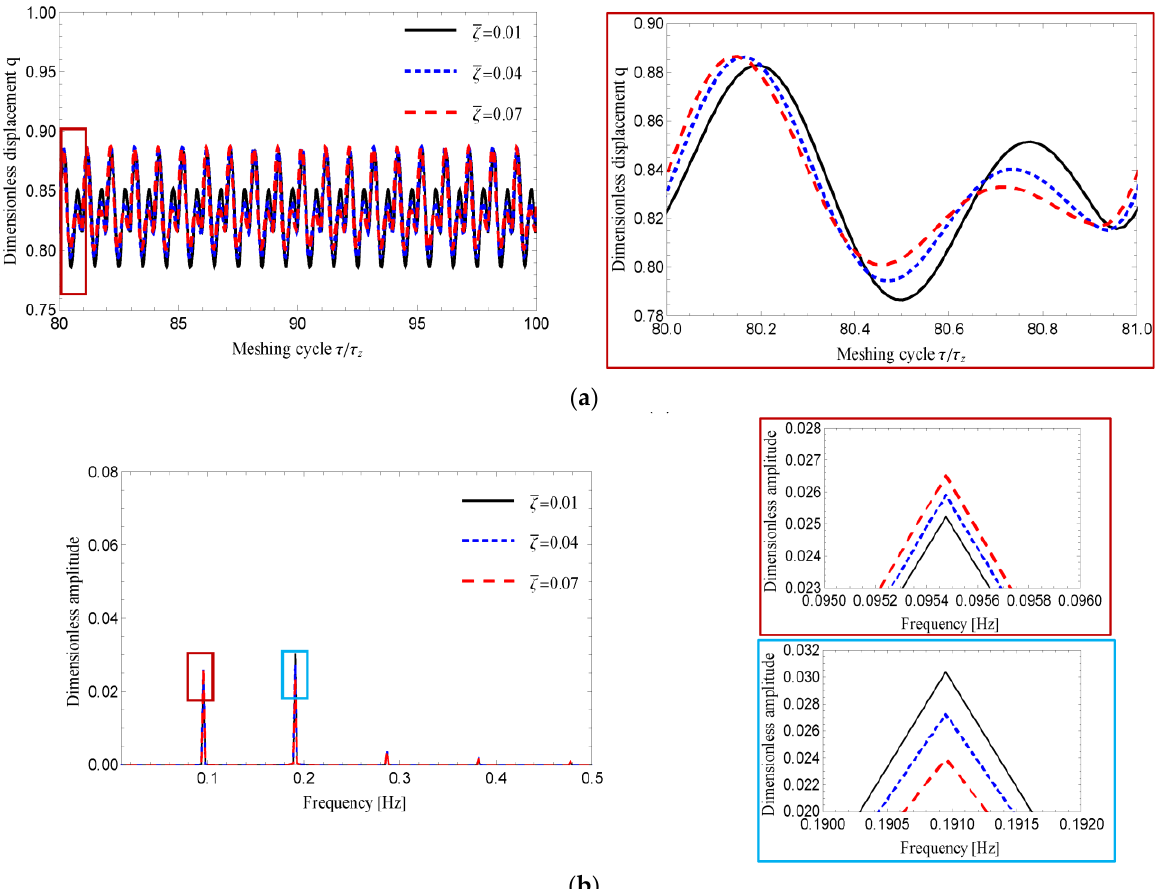
Figure 26. The dynamics characteristics with differen t 𝜁̅ : ( a ) time history diagram; ( b ) FFT spectrogram.